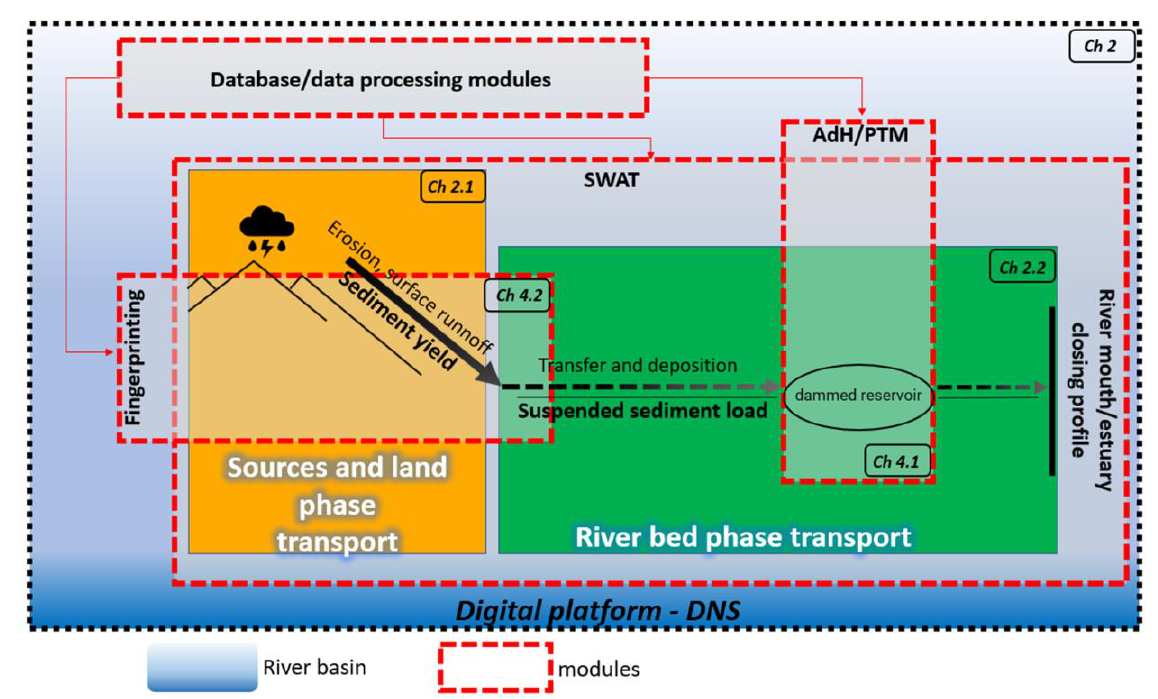
Figure 1. Methodological diagram (Ch. numbers — related paragraphs in the text.